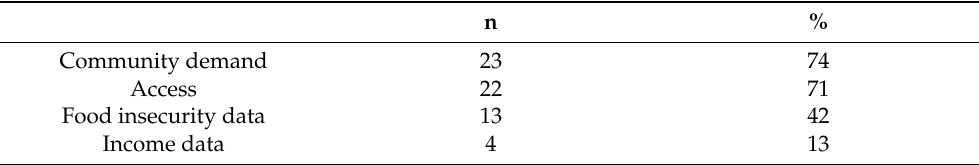
Table 5. Prioritization of Sites in 2020 for Markets that Changed Number of Sites.